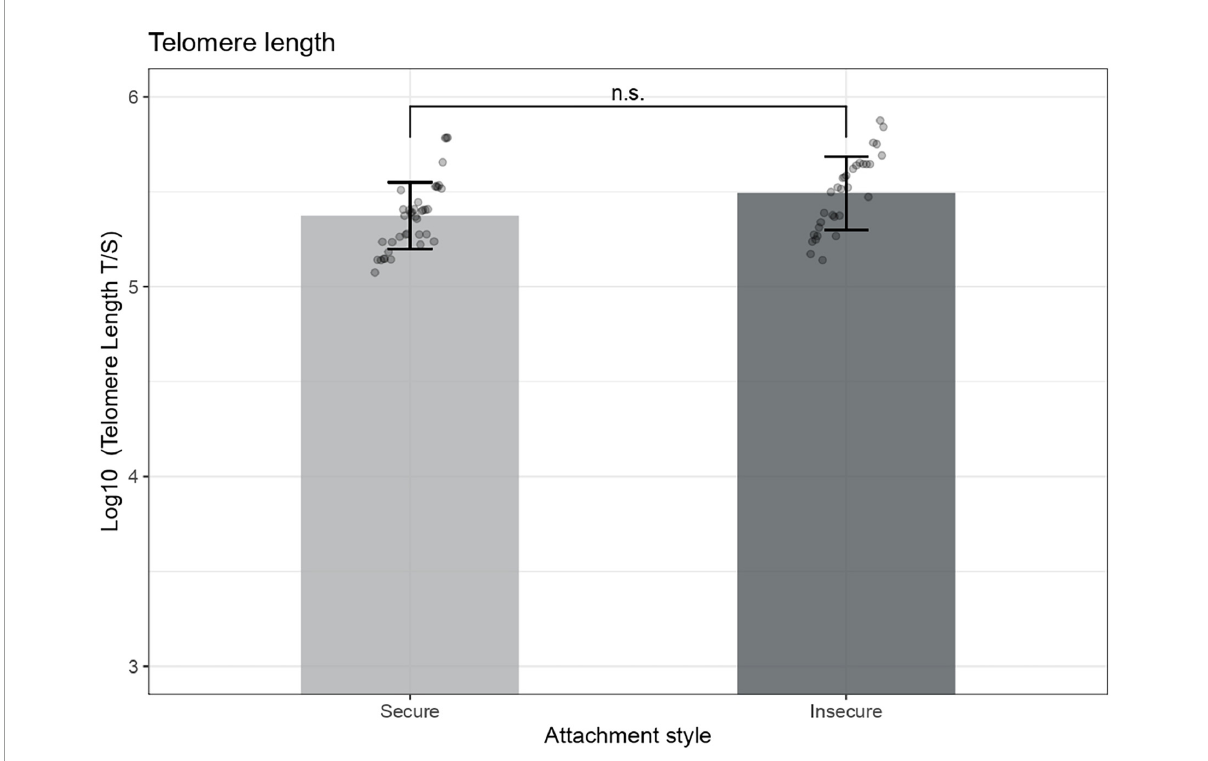
FIGURE4 Preschooler’s telomere length across attachment groups. Telomere length measures are adjusted for child’s age at sample collection, F (1,68) = 8.29, p = 0.005. Error bars represent 95% confidence intervals of the means, n.s. , Not